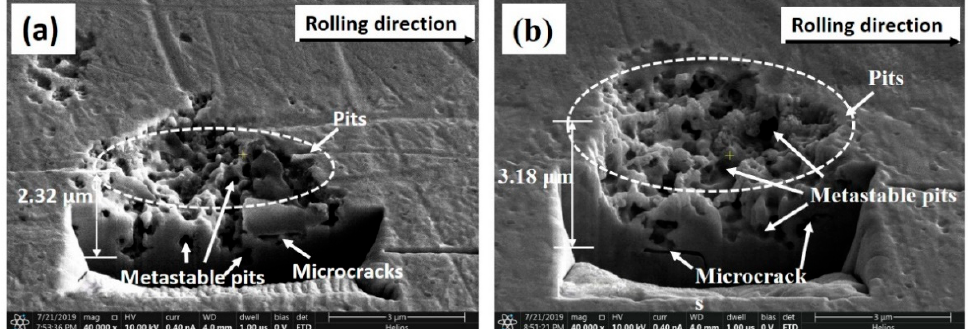
Figure 11. FIB-SEM cross-section microstructure of the corrosion pits of Cu strips under small and large reductions: ( a ) 22.7% reduction and ( b ) 77.3% reduction.